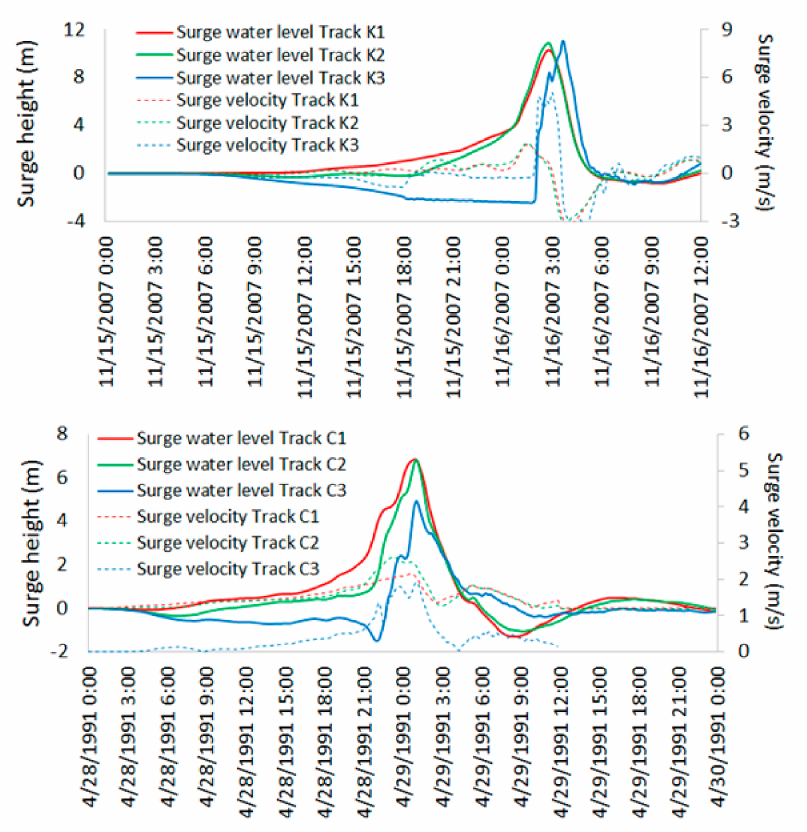
Figure 14. Surge water level profiles and surge velocity from “surge only” runs at the Khulna coast ( upper panel ) and the Chittagong coast ( lower panel ) for three different cyclone landfall crossing